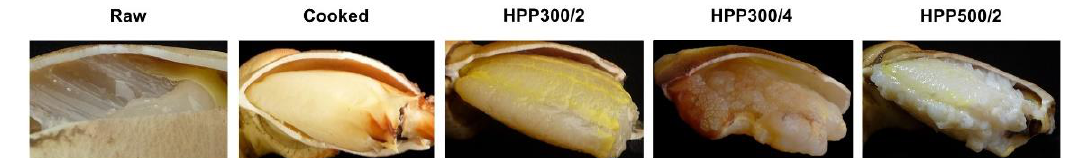
Figure 2. Detail of the detachment of the muscle tissue from the inner layer of the cuticle in cooked and high-pressure processed chelipeds of edible crab ( Cancer pagurus ) compared with their raw (i.e., untreated) counterparts. Sample codes: HPP300/2 and HPP300/4, high-pressure processed at 300 MPa for 2 and 4 min, respectively; HPP500/2, high-pressure processed at 500 MPa for 2 min.